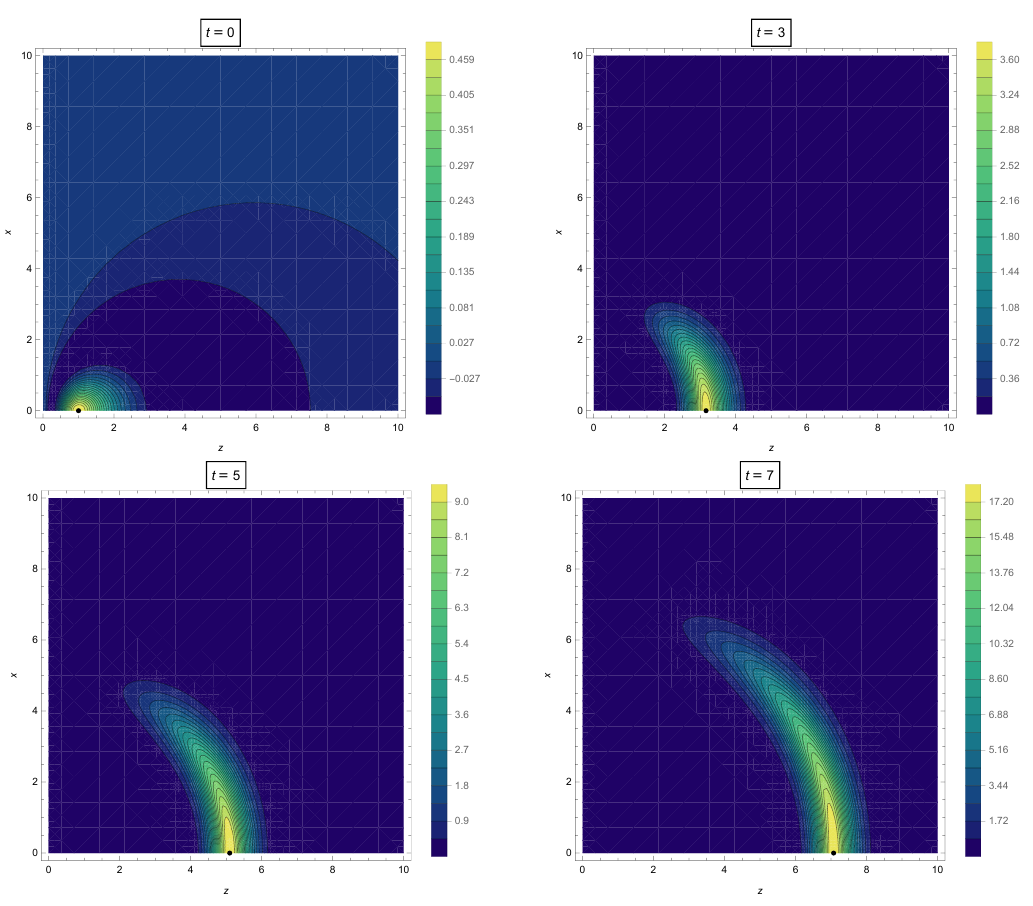
Figure 4 : Contour lines of constant energy density for fixed time. The monopole center is represented by the black spot. The numerical values A = 1 and L = 1 have been